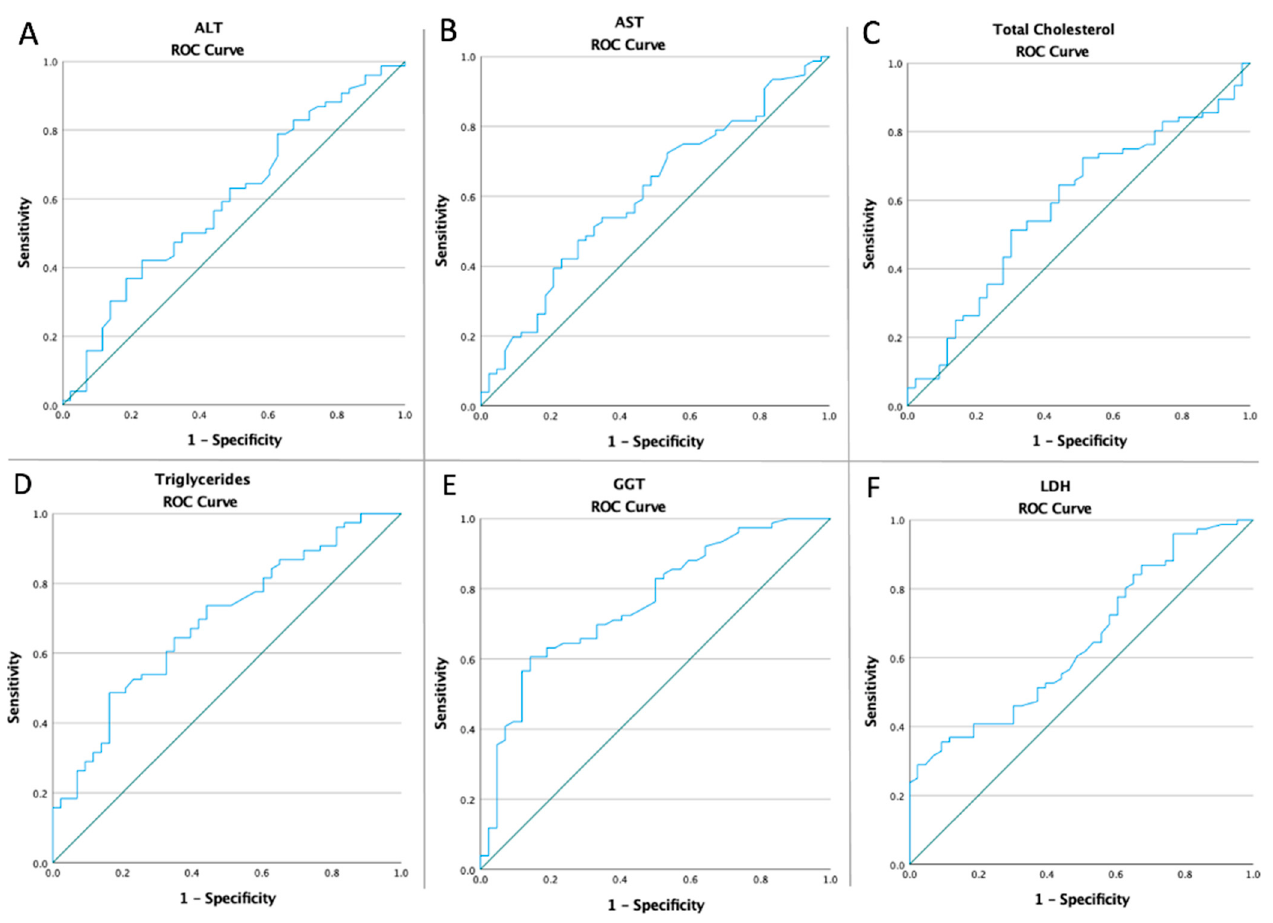
Figure 5. ROC Curve analyzed the NAFLD risk in terms of the laboratory parameters ( A ): ALT